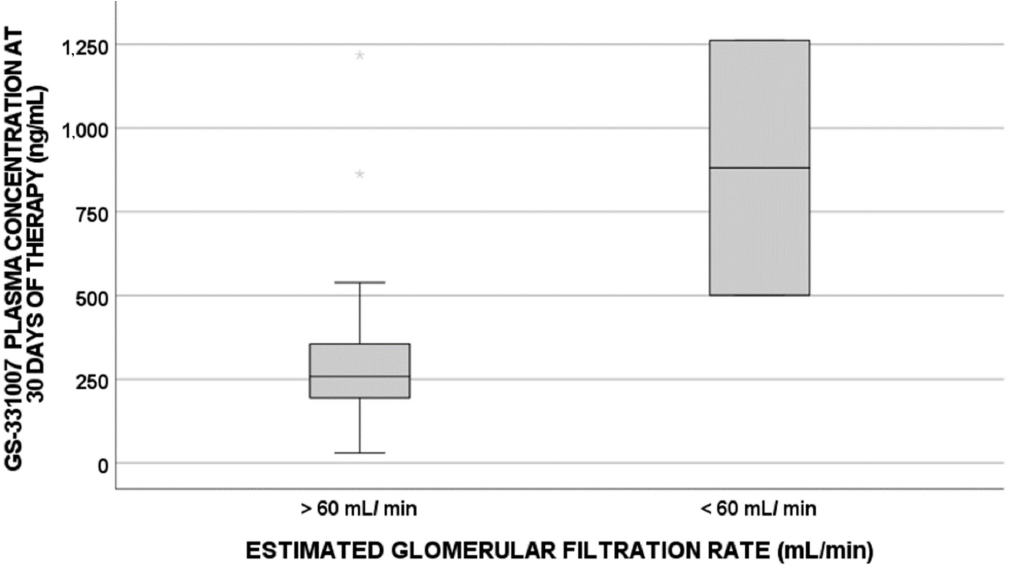
Figure 4. GS-331007 plasma levels at 30 days of therapy correlated with the baseline estimated glomerular filtration rate cutoff value of 60 mL/min ( p -value = 0.032; N = 48 for >60 mL/min; N = 2 for < 60 mL/min). No associations were observed between genetic polymorphisms and GS-331007 IC exposure, when considering both all patients, and the genotypes 1 and 3 group. In the linear multivariate regression analysis (Table 5), demographic, clinical, viral, pharmacogenetic and pharmacokinetic factors influencing metabolite IC concentrations at 30 days of therapy were evaluated: LDV treatment [ p -value = 0.026, odd ratio (OR) 1412.863 (confidence interval (CI) 95%, 184.004; 2641.721)], baseline albumin ( p -value = 0.010, OR, − 70.093 (CI95%, − 121.996; − 18.00)) and baseline eGFR ( p -value = 0.029, OR − 22.677 (CI95%, − 42.890; − 2.464)) were significant predictors. When considering genotypes 1 and 3, LDV treatment ( p -value = 0.048, OR 1415 (CI95%, 11.7; 2818.5)) and baseline albu- min ( p -value = 0.018, OR − 71.3 (CI95%, − 129.3; 13.4)) were retained in the regression model. No SNPs remained in the multivariate analyses. Table 5. Linear regression analyses: parameters able to predict GS-331007 metabolite ICs at 1 month of therapy. BMI: body mass index; ALT: alanine aminotransferase; eGFR: estimated glomerular fil- tration rate.